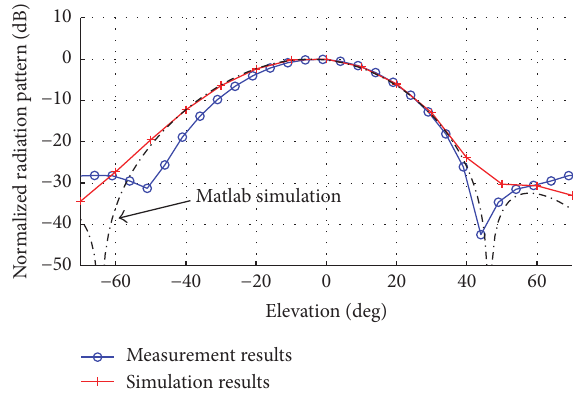
Figure 12: V plane radiation pattern at 922.5